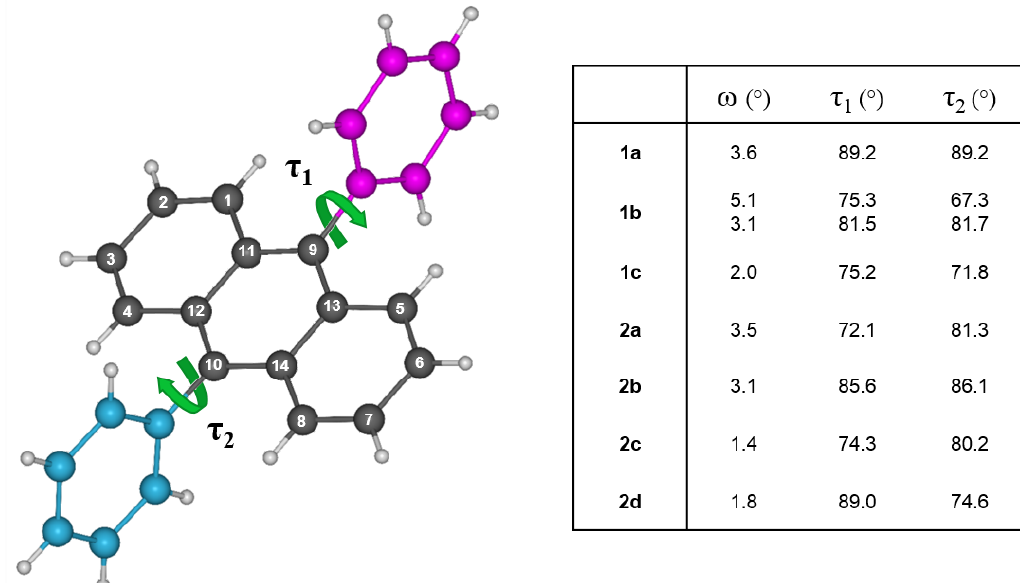
Figure 4. Molecular distortions depicted by the dihedral angle ( ω ) between intersecting planes from the outer blades of the anthracene backbone (C1–C4 and C5–C8) and the mean torsion angles ( τ ) between pendant aryl groups and anthracene unit. Compound 1b contains two unique molecules in the asymmetric unit.